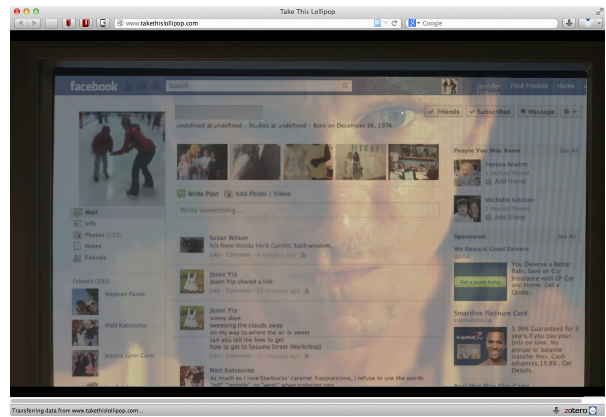
Figure 1. A screen capture of the creepy Facebook Stalker looking at a person’s profile, taken as a screen capture from the Take This Lollipop video, the app used in our